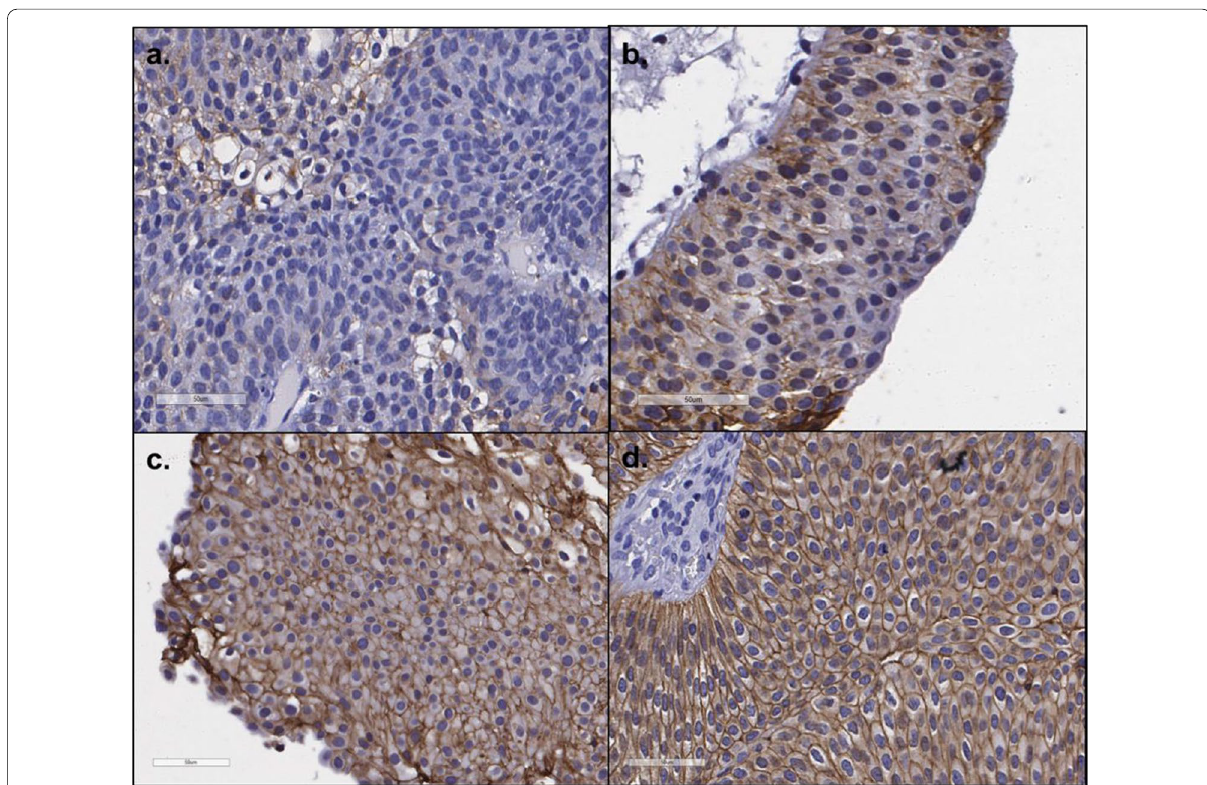
Fig. 1 Immunohistochemistry of antibody-stained FFPE bladder cancer preparation for E-cadherin was done per specimen counting minimum of 1000 cells using Aperio Imagescope (Leica Biosystems, Buffalo Grove, IL, USA); a. field dominant with 0 expression mark ( field dominant with 1 expression mark ( 400); c. field dominant with + × ( ×